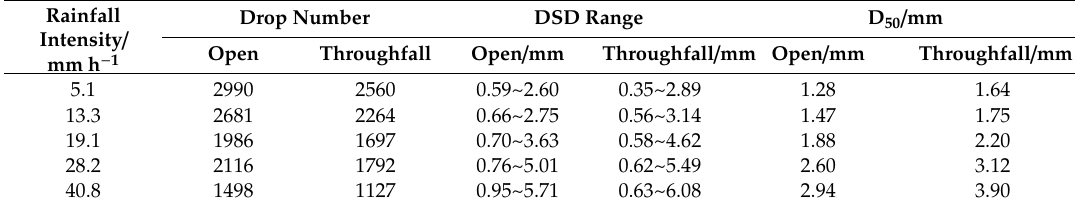
Table 3. Drop size distribution (DSD) information for different rainfall events.